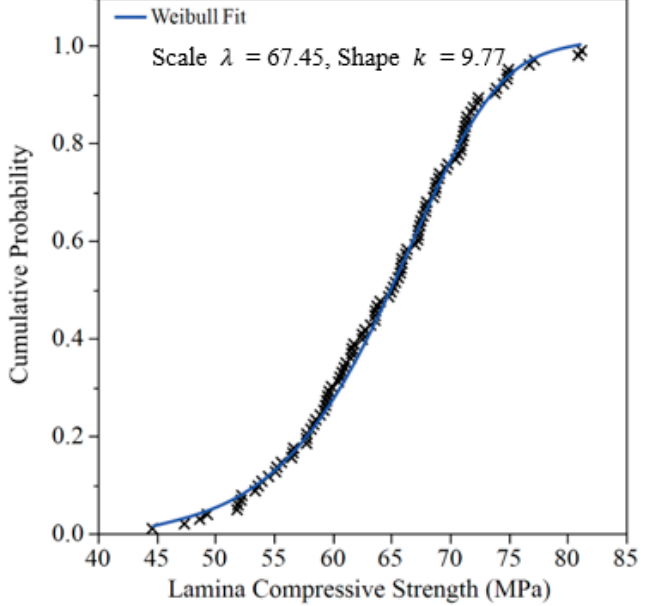
Figure 6. Cumulative probability of compressive strength for lamina and fit by the Weibull distri- bution.